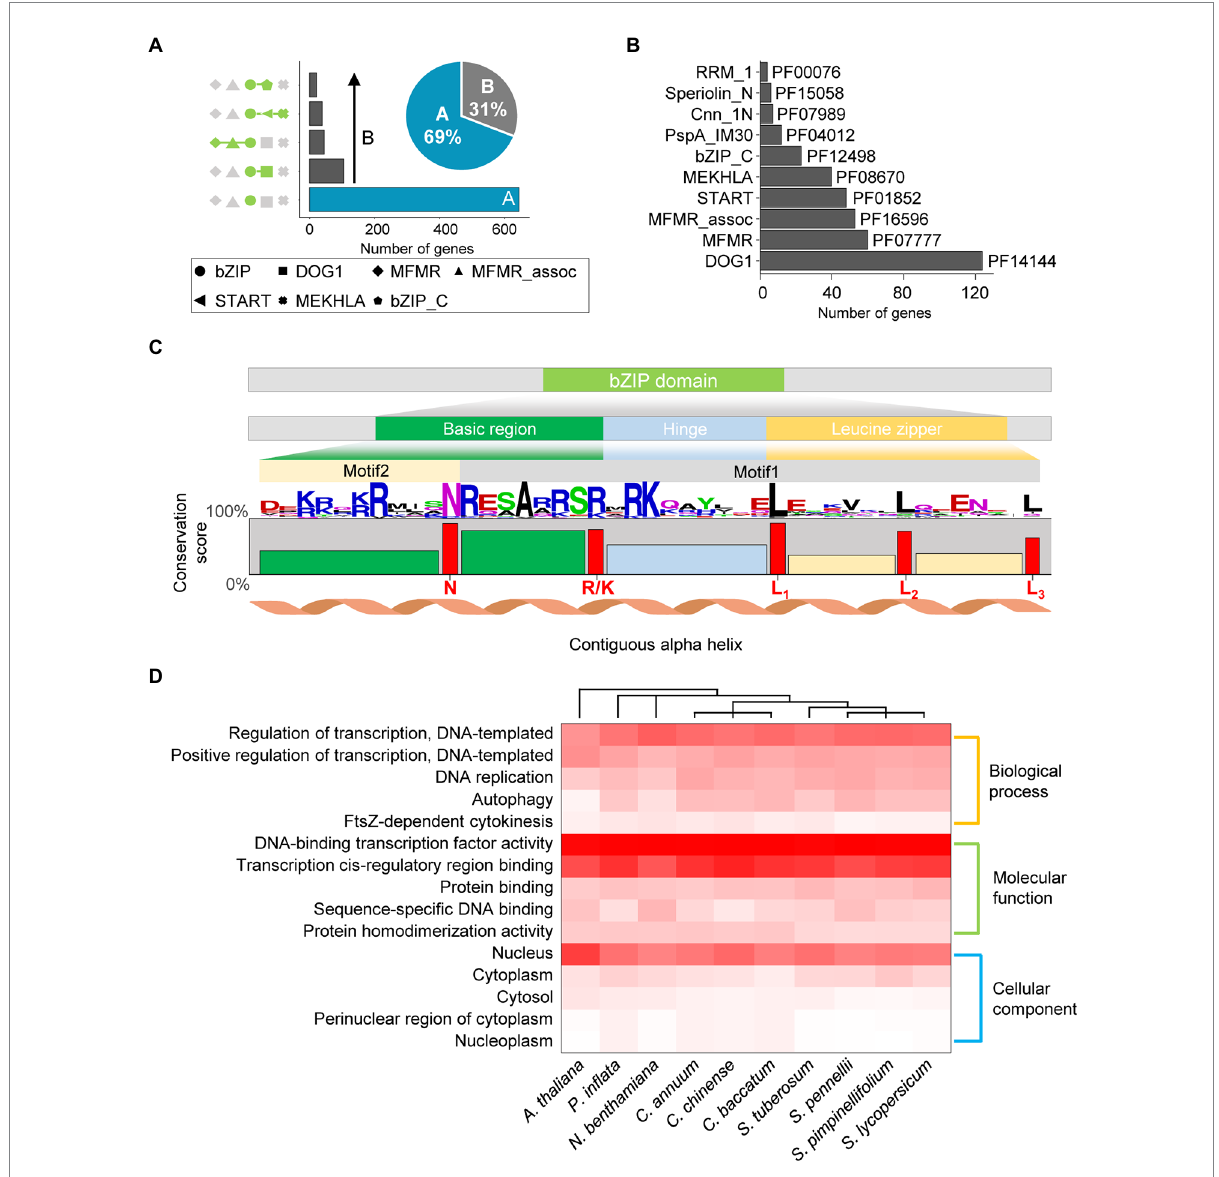
FIGURE 1 Characteristics of bZIP genes in Solanaceae. (A) The number of genes with the top five domain architecture repertoires is illustrated in the bar chart. Different domain architectures are shown on the left of the chart; domains are defined by different shaped symbols as defined below the chart. The percentages of the two types of bZIP genes are presented in the pie chart. (B) The bar chart shows the number of genes with integrated domains (top 10). Pfam IDs of the integrated domains are labeled next to the chart. (C) The amino acid sequence of the bZIP domain in 10 species. The height of the amino acid residue indicates the relative frequency of each amino acid at the specific position. The conservation scores of each compartment and residues are displayed as bar plots. The bar colors represent three regions of the bZIP domain: green, basic region; light blue, hinge region; and yellow, leucine zipper region. Red letters below the bar plots represent significantly conserved residues in bZIP genes. (D) Distribution of gene ontology (GO) terms of bZIP genes. The three GO categories are displayed on the right side of the heat map. The top five GO descriptions in each category are shown in the heat map. The colored scale at the bottom right side of the heat map represents the proportion of bZIP genes in each